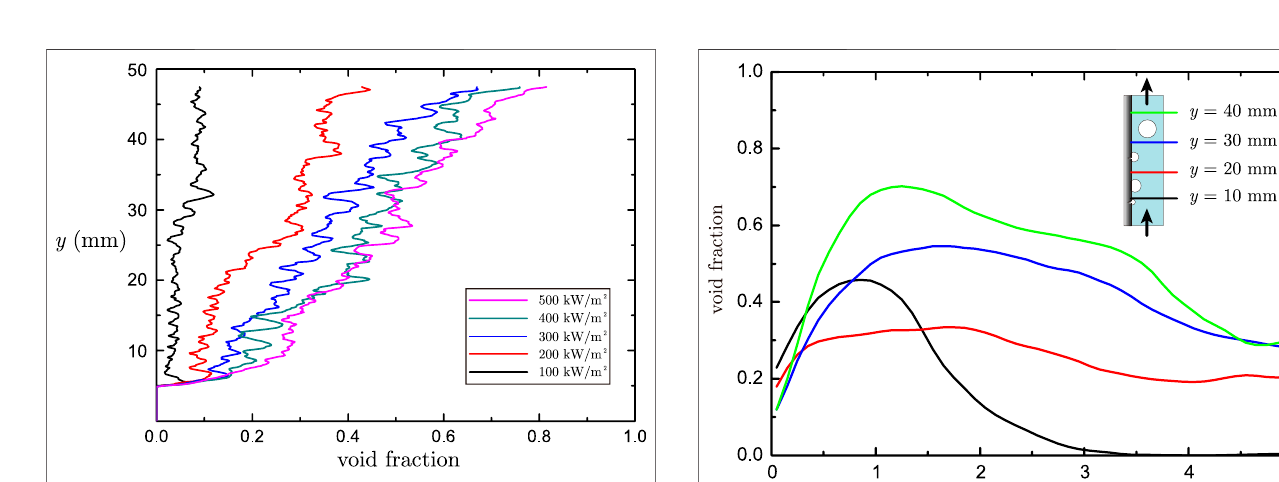
FIGURE 12 | Void fraction obtained by time averaging the vapor volume fraction.